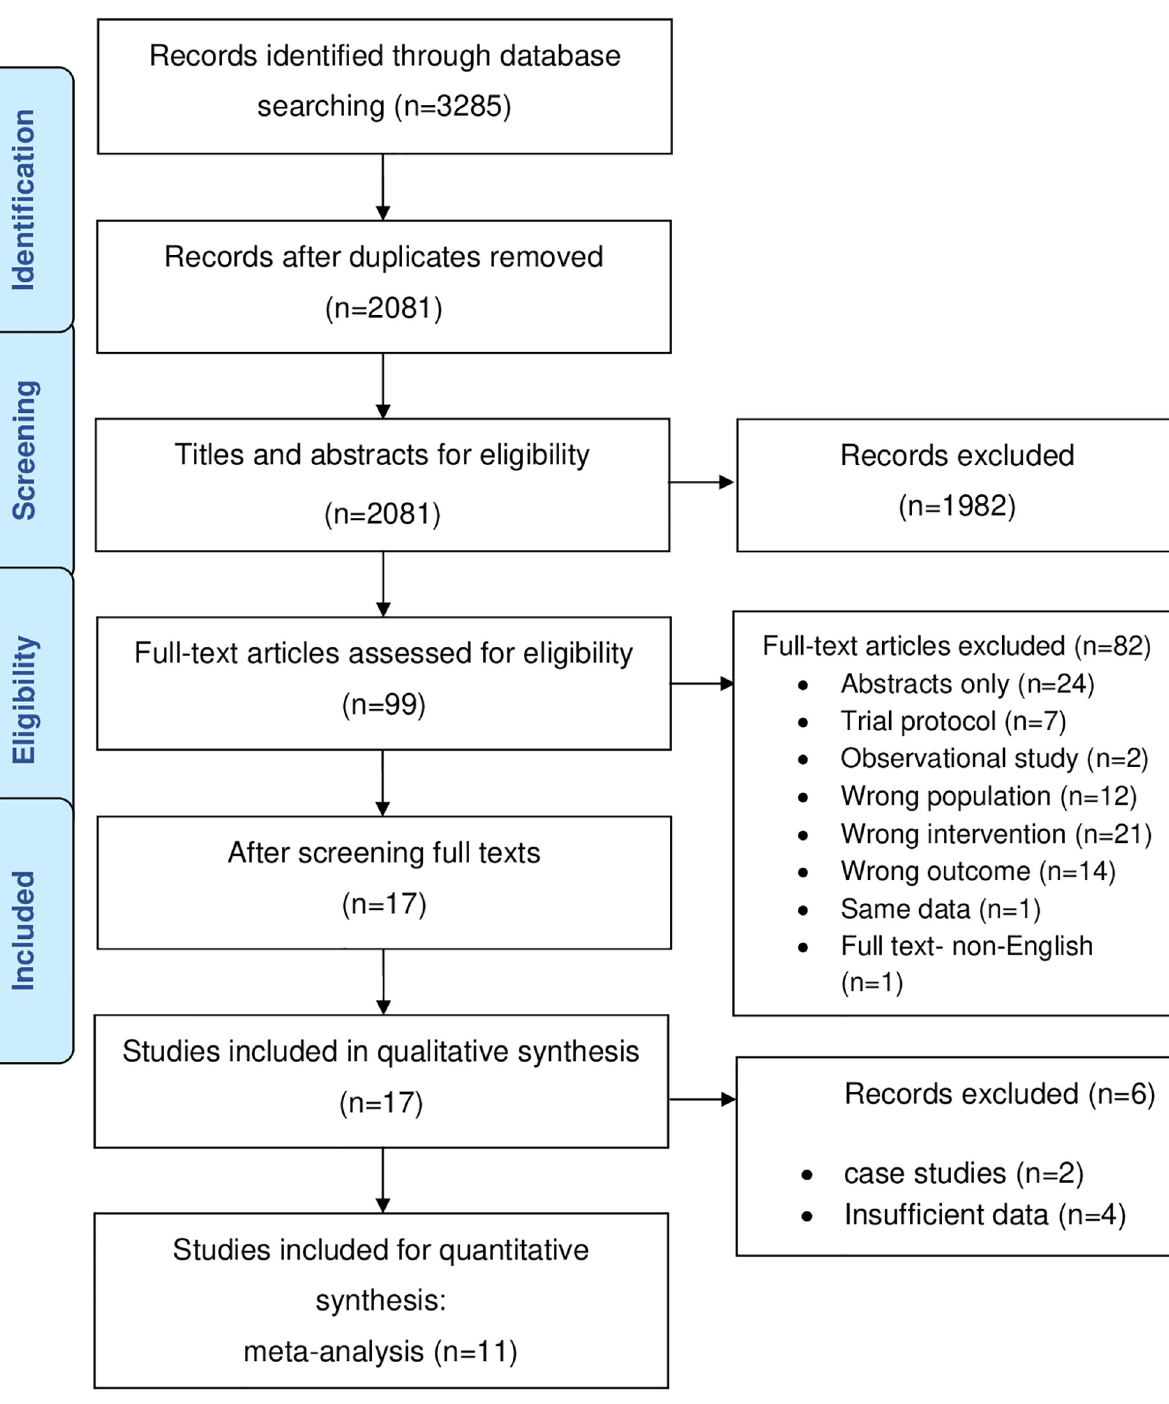
PLOS ONE | https://doi.org/10.1371/journal.pone.0274874 September 21,